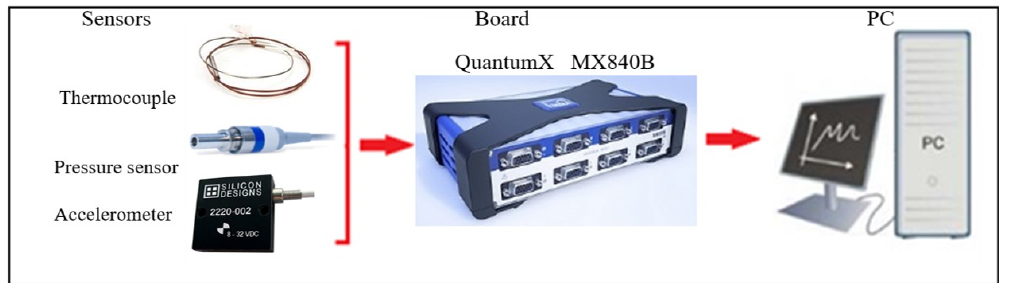
Figure 1. Diagram of the data acquisition system for vehicle experiments.